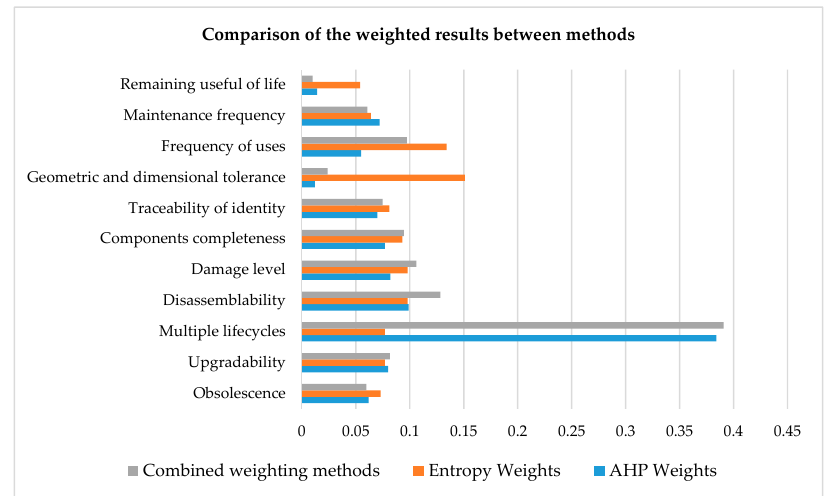
Figure 7. Comparison of the weighted results of the methods.